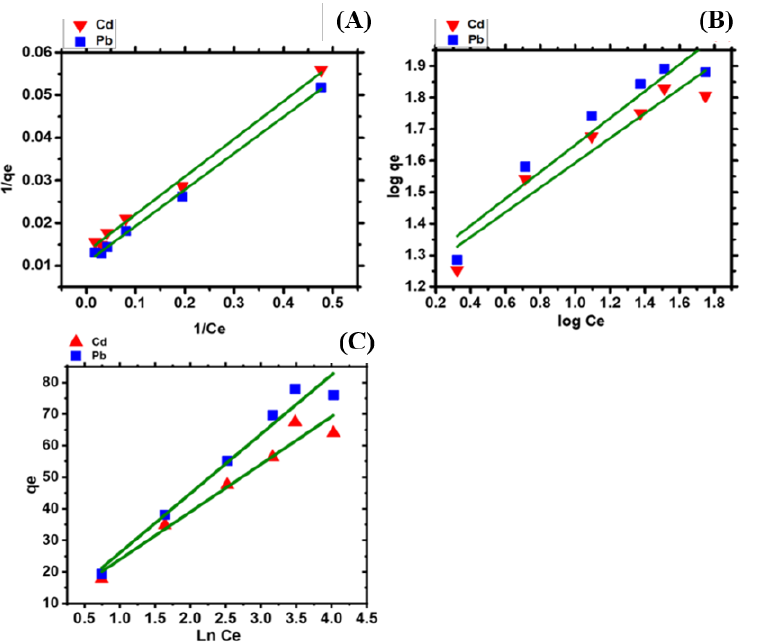
Figure 6. ( A ) The Langmuir, ( B ) Freundlich isotherm, ( C ) Temkin isotherm for biosorption of Cd and